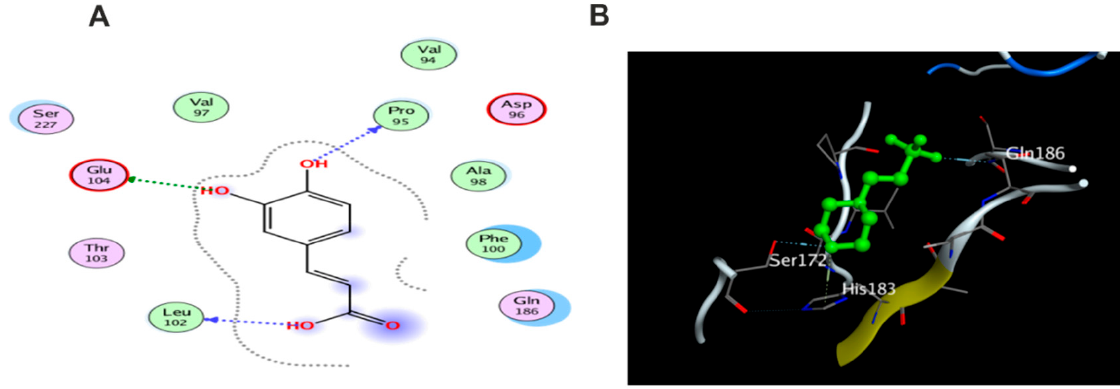
Figure 21. ( A ) 2D interaction of kaempferol with amino acid residues ( B ) 3D pose of kaempferol in the active pocket site MMP2 (PDB ID